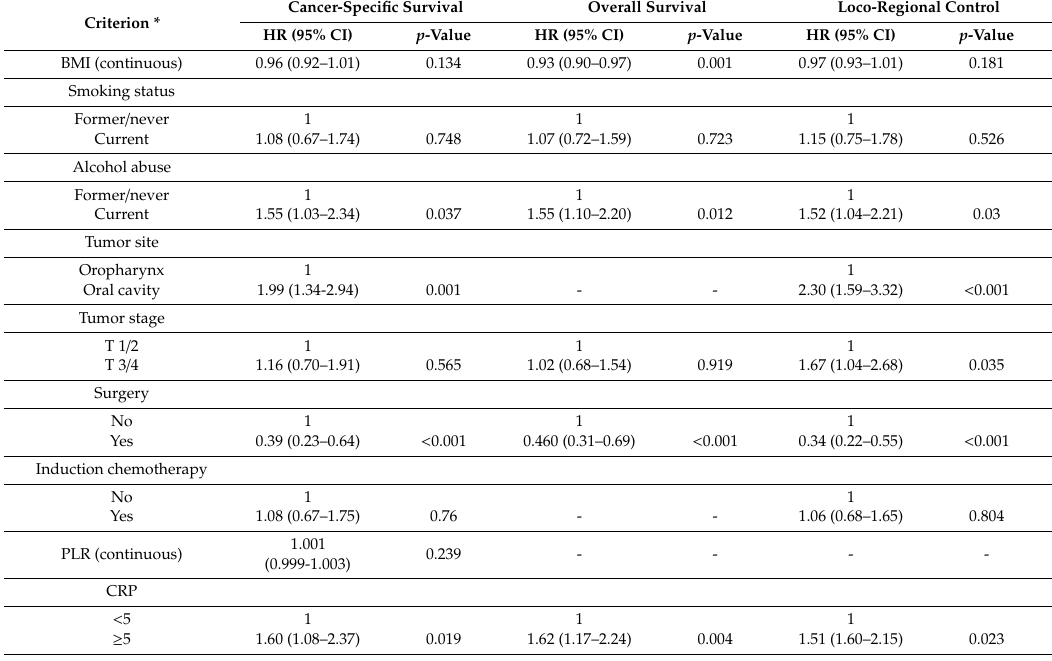
* Multivariate Cox proportion analysis included parameters significantly associated with outcome in univariate